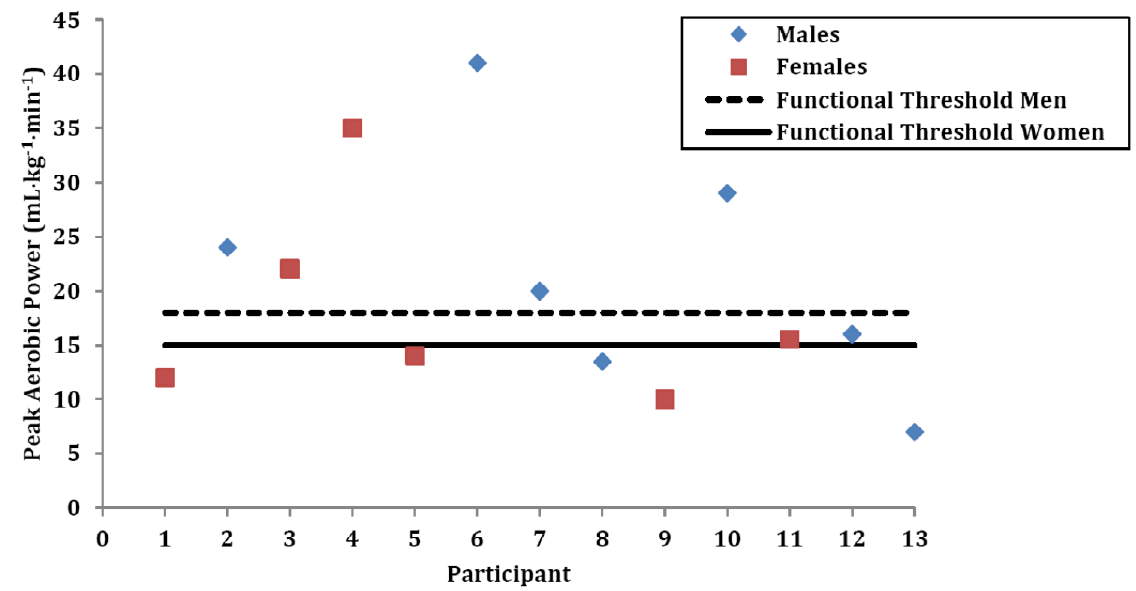
Figure 1. Aerobic fitness of the 13 participants at